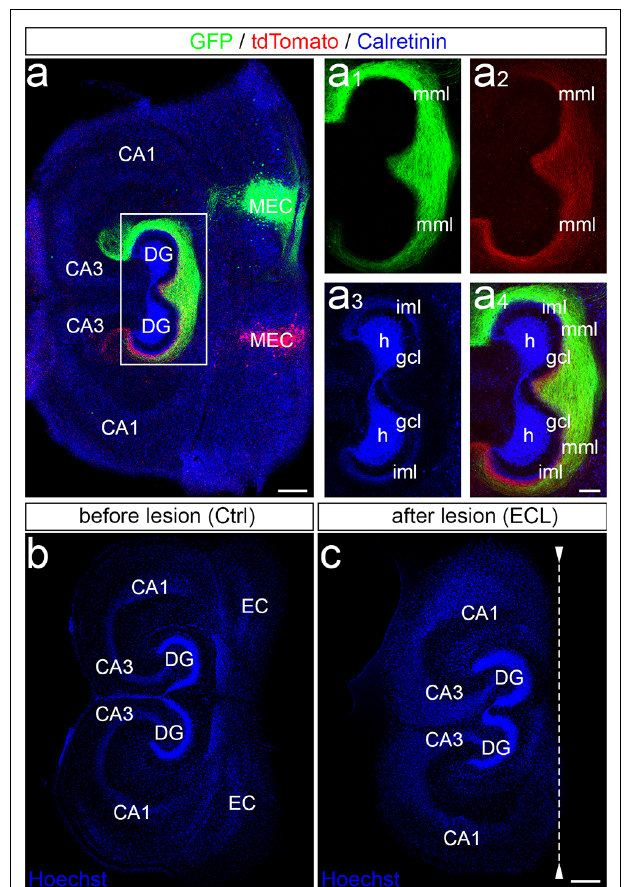
FIGURE 1 | Entorhinal projection and entorhinal lesion in vitro . (A) Viral tracing was employed to visualize the entorhino-hippocampal projection in double cultures. One medial entorhinal cortex (MEC) was injected with an adeno-associated virus transducing a green construct (AAV2-hSyn-GFP) and the other MEC was injected with a virus transducing a red construct (AAV2-hSyn-tdTomato). In addition, calretinin-immunofluorescence labeling was used to visualize the mossy cells and their axons (blue; overexposed channel to visualize the axons in the inner molecular layer). CA3, CA1, hippocampal subfields CA3, CA1; DG, dentate gyrus; h, hilus; gcl, granule cell layer; iml, inner molecular layer; mml, middle molecular layer. Scale bar: 200 µ m. (A1–A4) Higher magnification of the dentate gyrus (DG) showing the termination pattern of green MEC axons (A1) , red MEC axons (A2) , calretinin-immunolabeled axons (A3) , and of all three projections (A4) . Scale bar: 100 µ m (A1–A4) . (B,C) Entorhinal denervation was performed under visual control. A section (30 µ m) of an old (DIV 28) double entorhino-hippocampal tissue culture is illustrated before (B) and after (C) lesion. Sections were fixed and nuclear staining with Hoechst was used to show that the entorhinal lesion leaves the DG and hippocampus proper intact. EC, entorhinal cortex. Scale bars: 250 µ m (B,C)